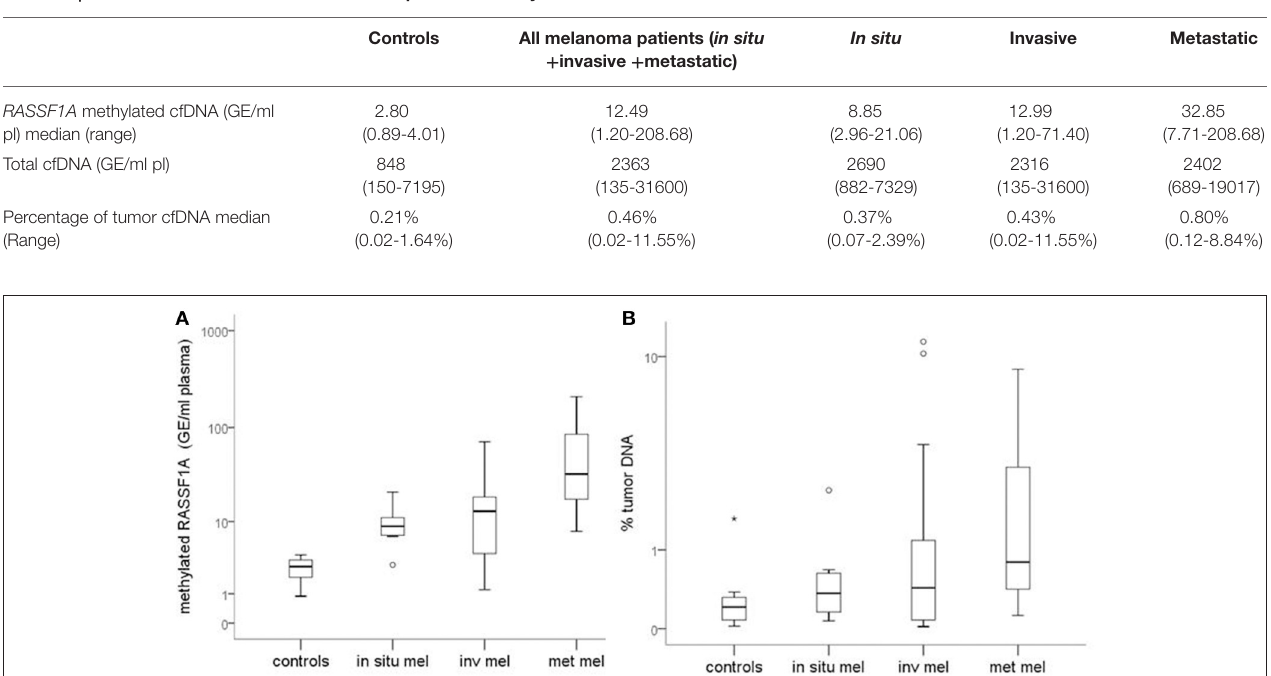
TABLE 2 | Quantitative data relative to RASSF1A promoter methylation.